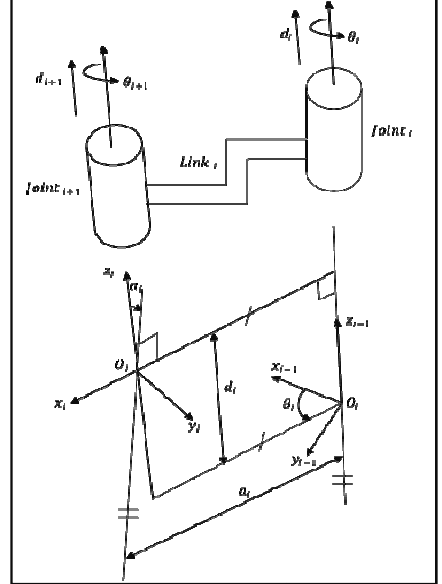
Fig. 2. The Denavit-Hartenberg